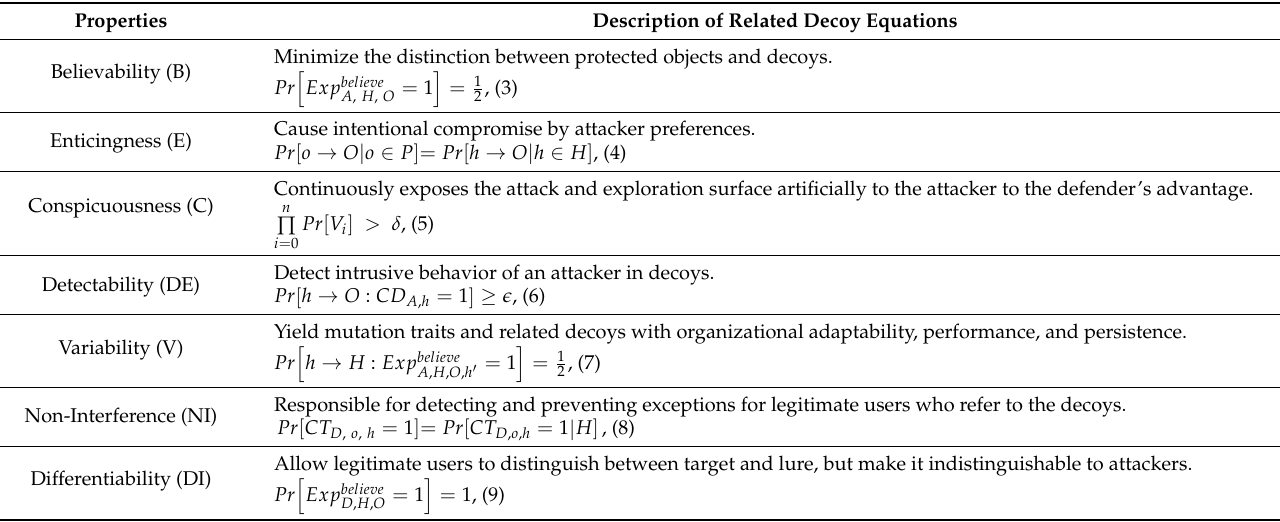
Figure 3. Lower-level overview of HS-Decoy with major features. Table 3. Configuration of organizational OSINT-based HS-Decoy properties and major equations.